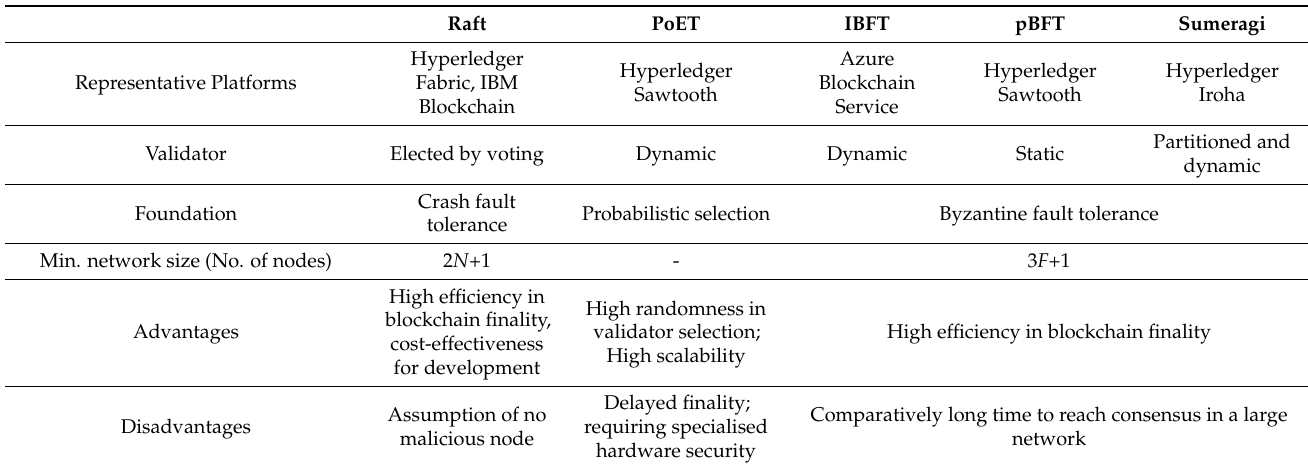
Table 3. Comparison of consensus algorithms for developing consortium